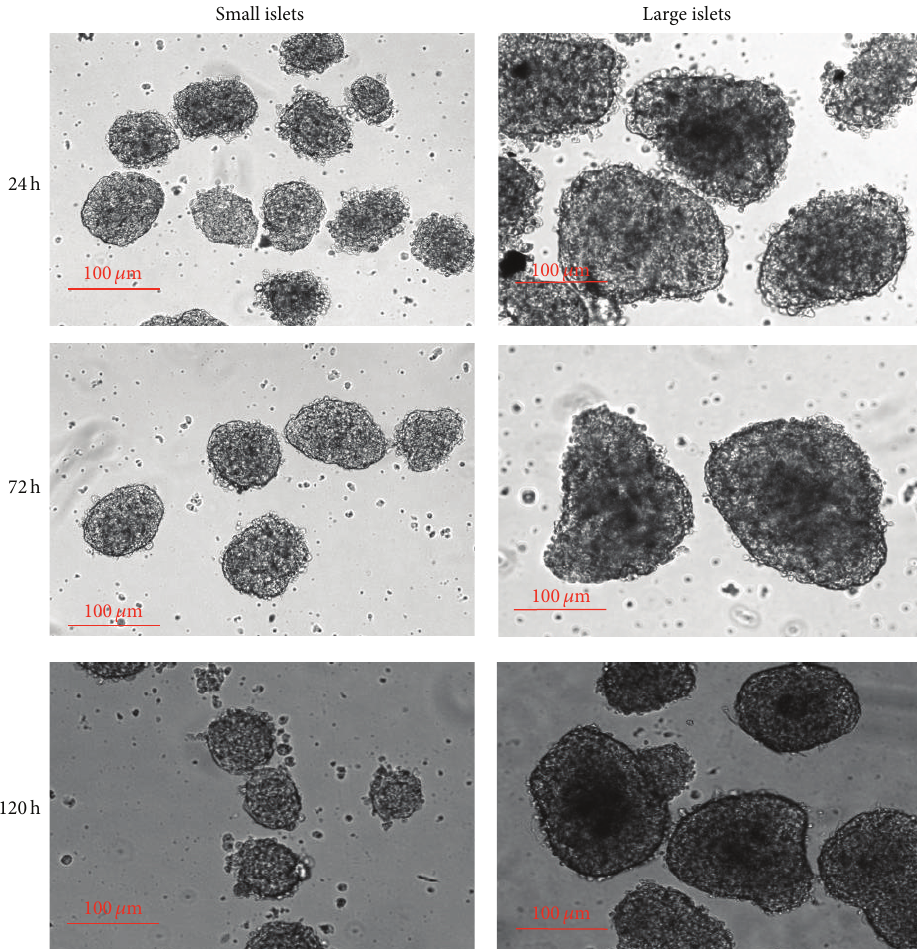
Figure 1: Typical morphology of small and large islets incubated in vitro with indicated time. Note the expanded central reduction of light transmittance within the large